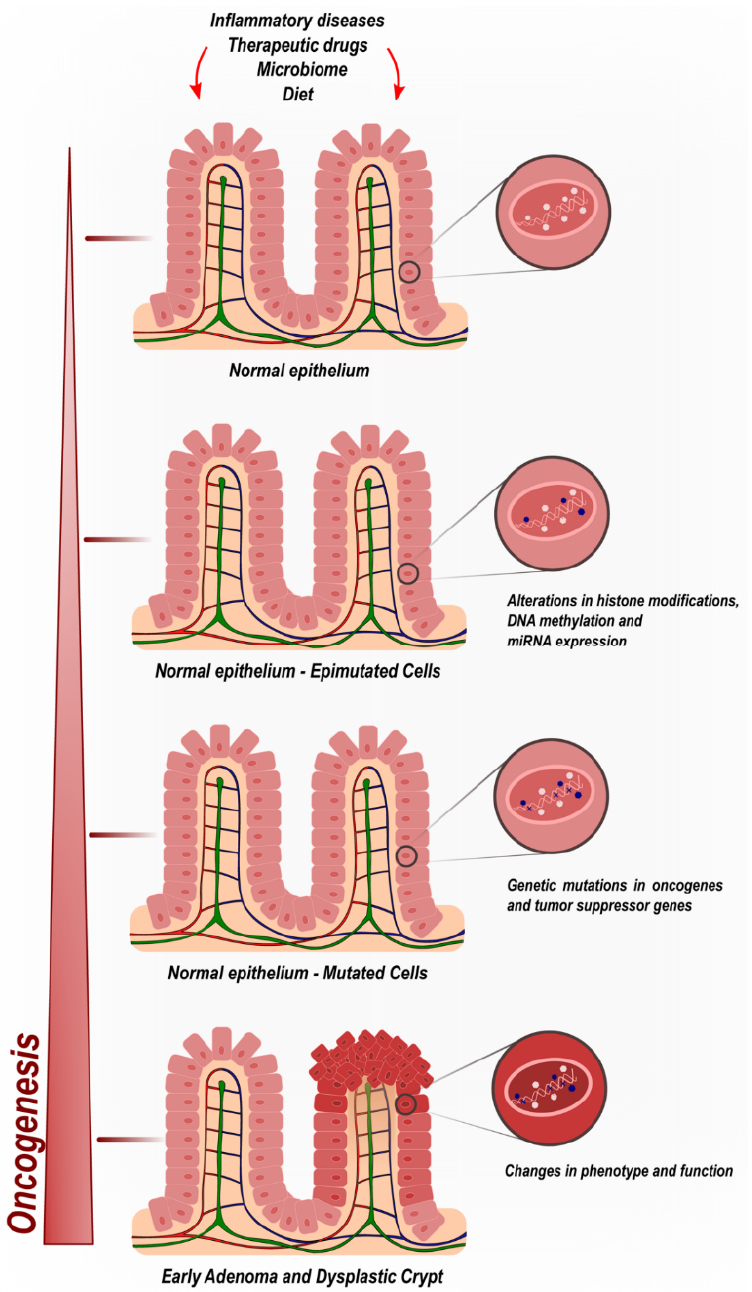
Figure 1. Colorectal cancer oncogenic progression by cumulative epigenetic and genetic deregula- tory mechanisms.